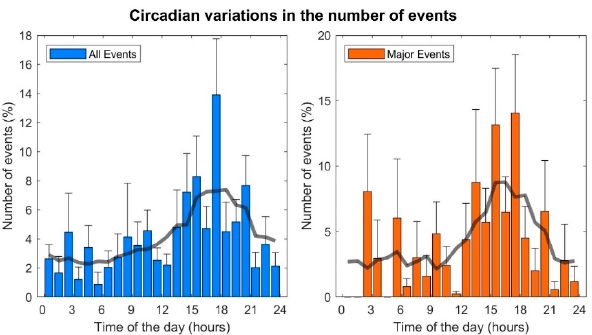
Figure 1. Distribution of events during the day. Bars: average hourly incidence of events computed across different years. Whiskers: standard error. Solid line: moving average.